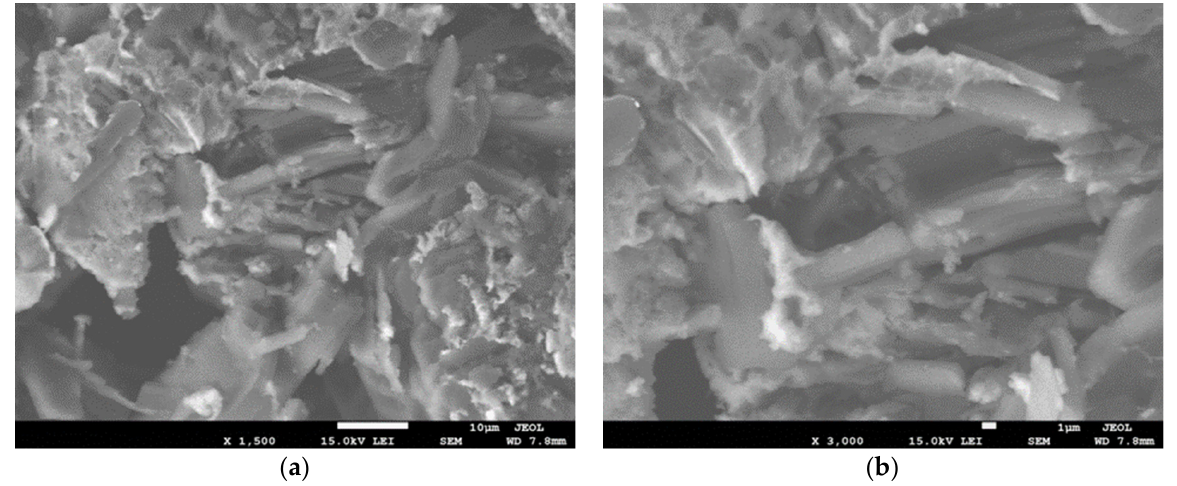
Figure 2. SEM images of the ZnS nanoparticles: ( a ) lower, and ( b ) higher magnifications.